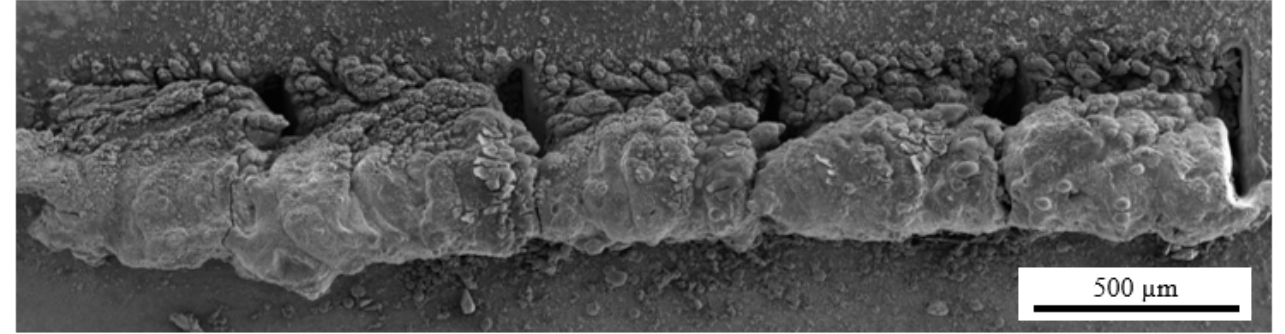
Figure 5. Example of the accumulation of material inside a groove when high laser energy is used ( P = 100%, s = 100 mm/s, and n = 128).